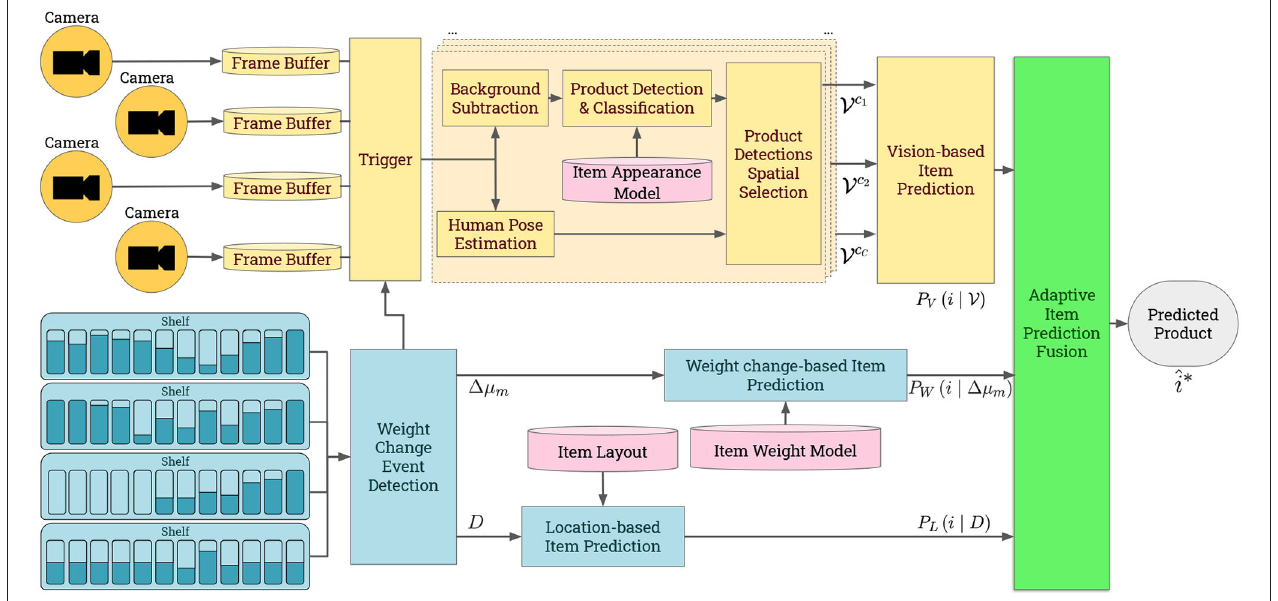
FIGURE 2 | FAIM system overview. (Top) Vision-based pipeline (yellow). (Bottom) Location- and Weight change-based prediction pipeline (blue). (Right) Fusion algorithm (green). Prior knowledge of item layout, weight and appearance